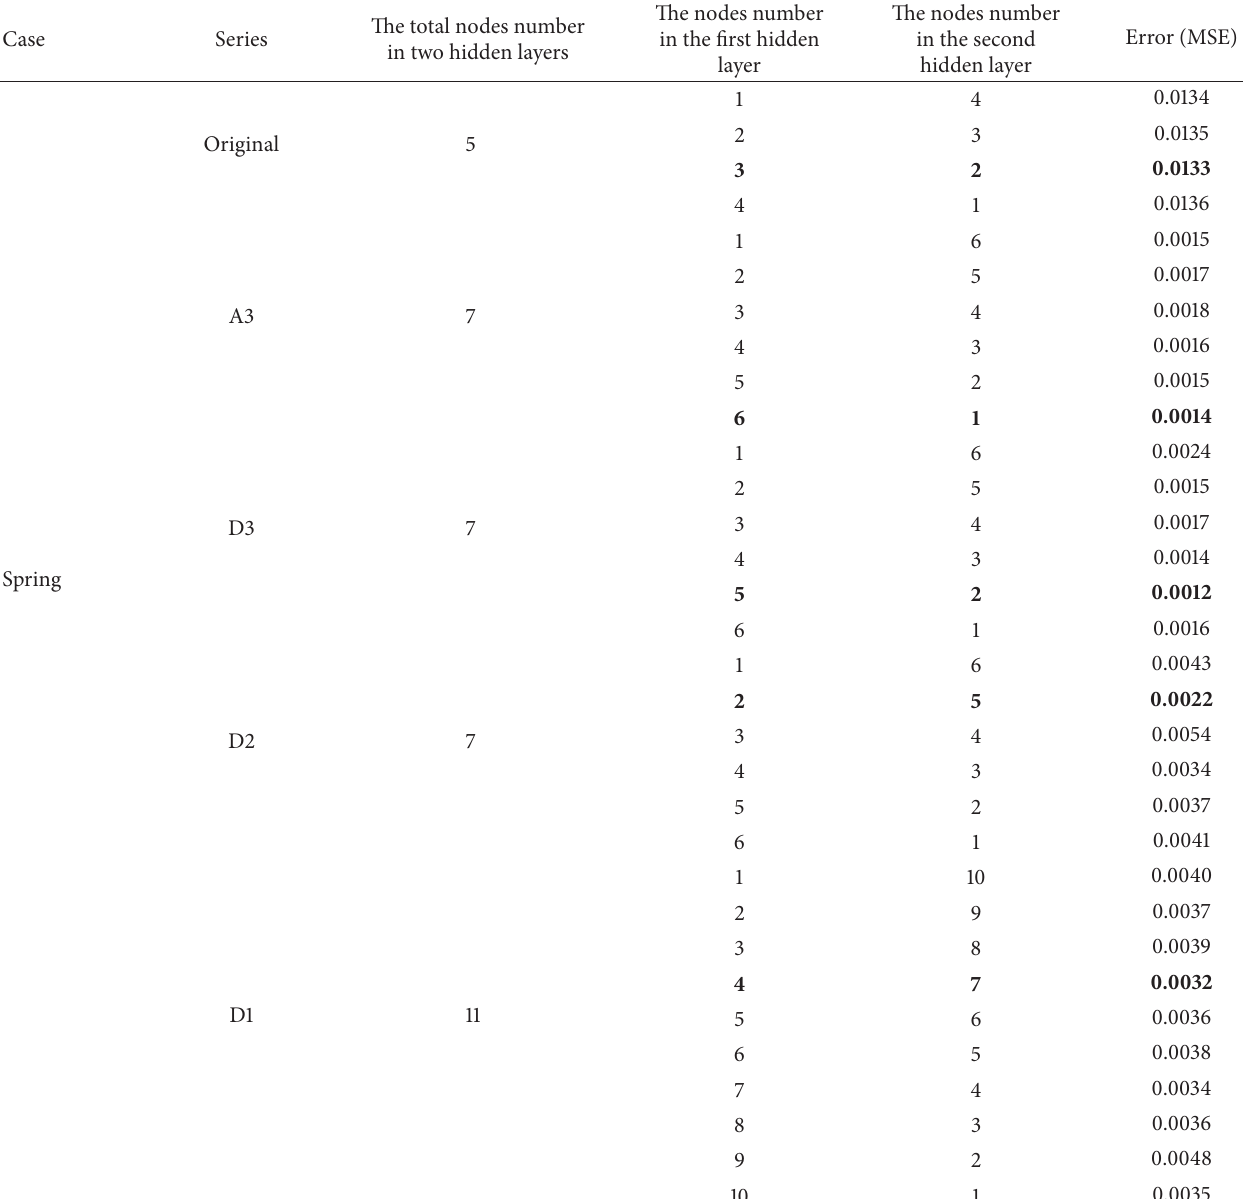
Table 3: The choice of nodes number of the hidden layers in